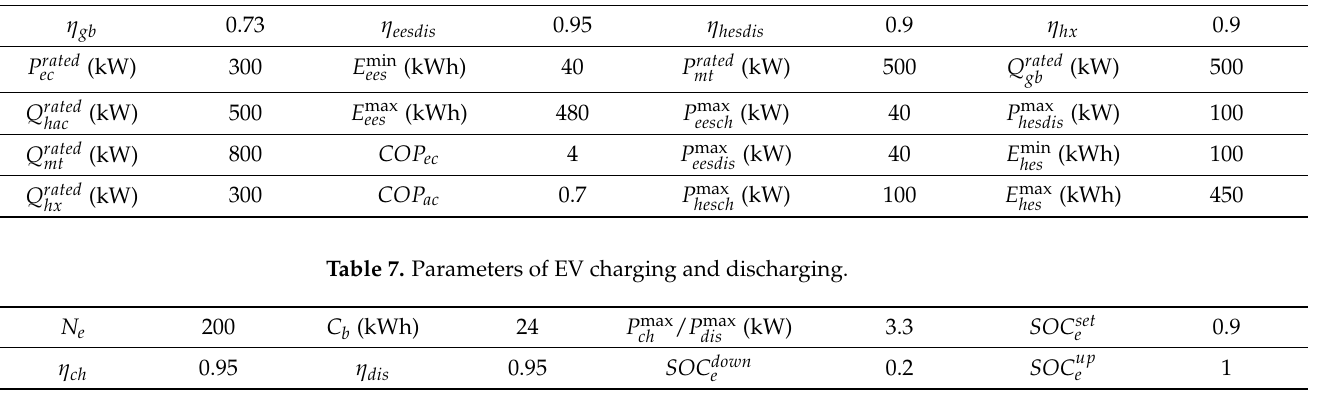
Table 6. Cooling and heating electrical equipment parameters.